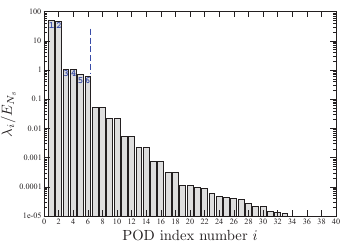
Figure 4. POD eigenvalues in logarithmic scale. E N